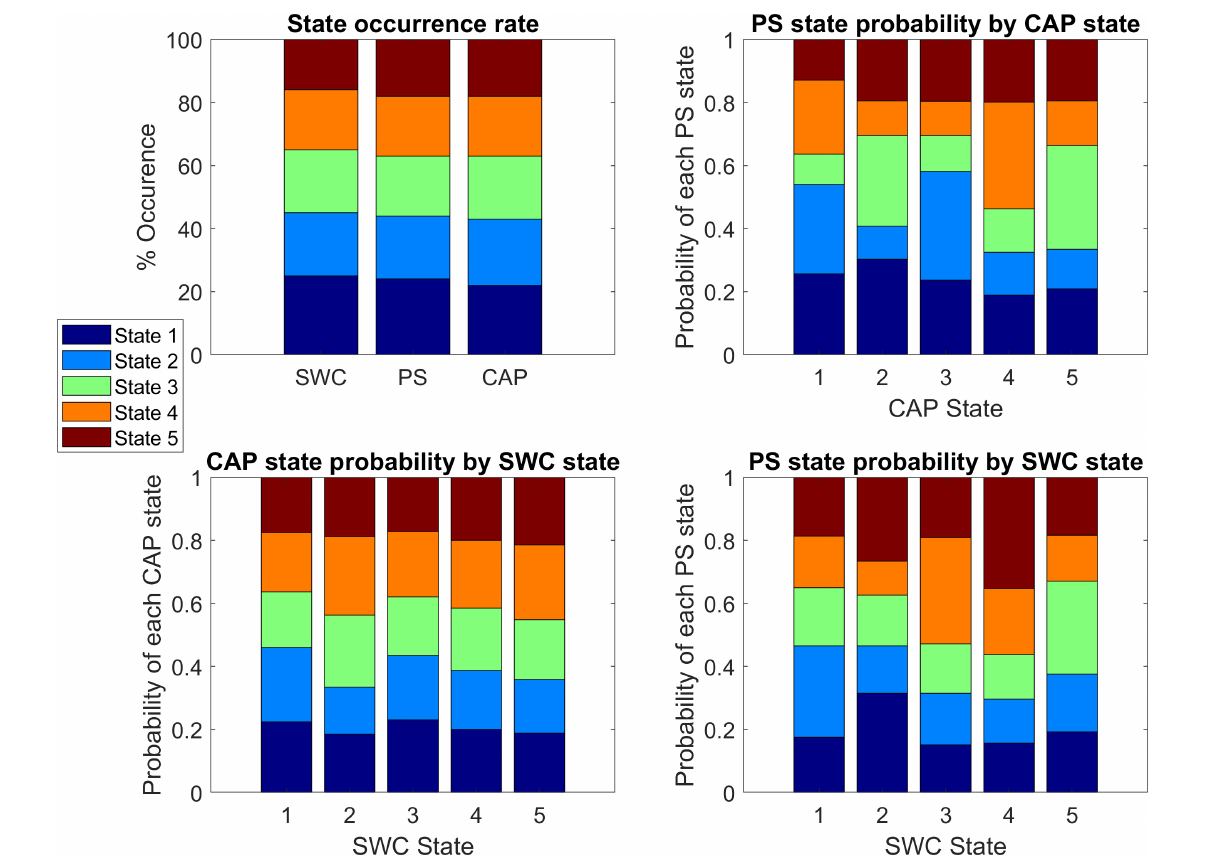
FIGURE 3 | Comparison of state composition across dynamics methods. Top-left shows the state occurrence rate of each analysis method with states sorted from highest occurrence (state 1) to lowest occurrence (state 5). Top-right shows the probability of a timepoint that belongs to a specified co-activation pattern (CAP) state corresponding to each of the five phase synchrony (PS) states. The bottom panels show the probability of a timepoint that belongs to a specified CAP state (Bottom-left) or PS state (Bottom-right) corresponding to each of the five sliding window connectivity (SWC) states.